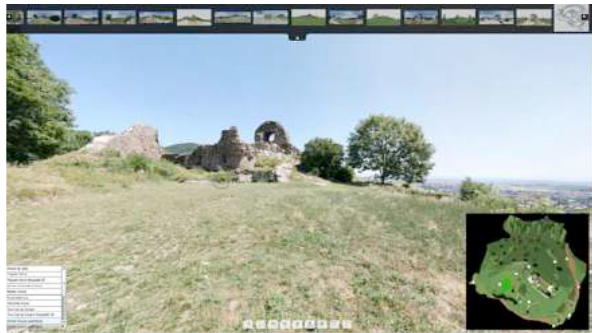
Figure 7. VT environment, Archeological area of Thann (M.